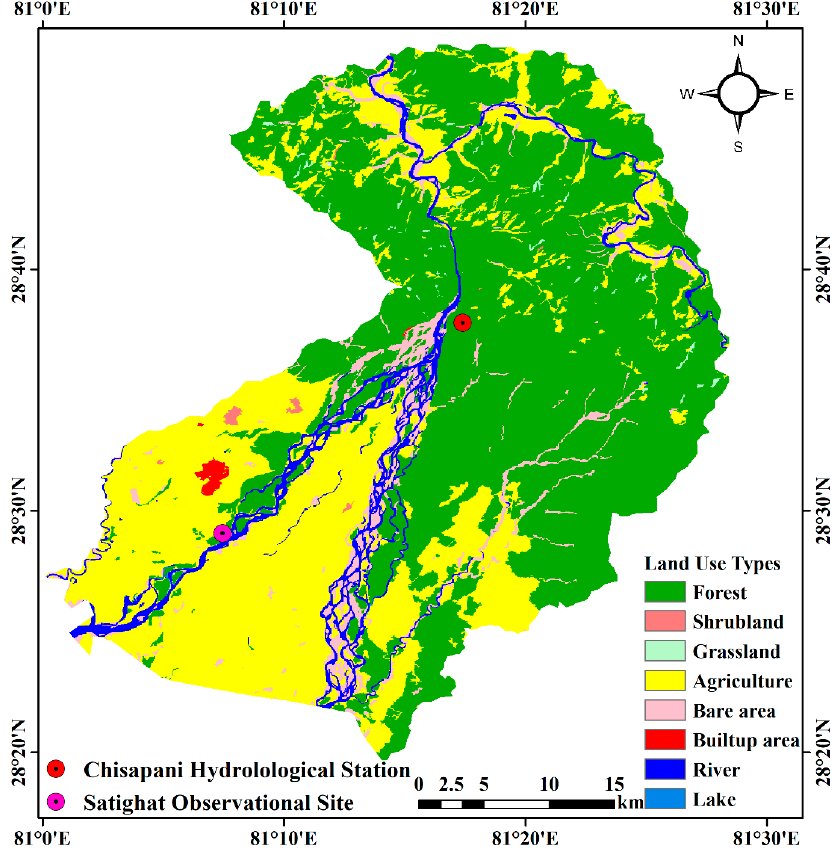
Figure 2. Land-use classification map of the study area.